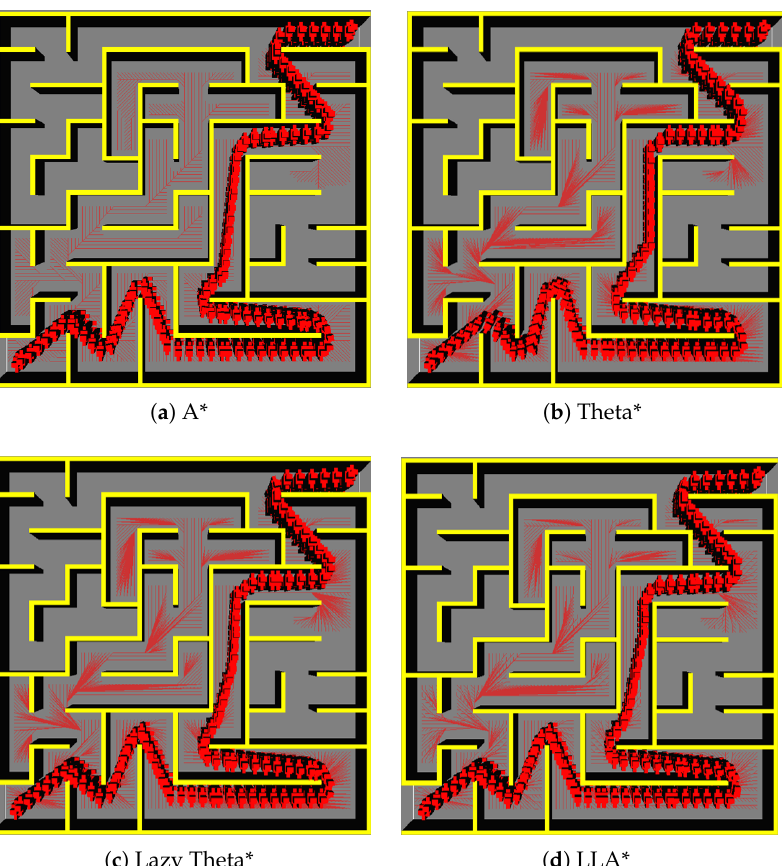
Figure 11. The planning results for an animated character using A* ( a ), Theta* ( b ), Lazy Theta* ( c ), and LLA* ( d ) on Maze #2. The extension details and final composite moving trajectories are shown in red color.